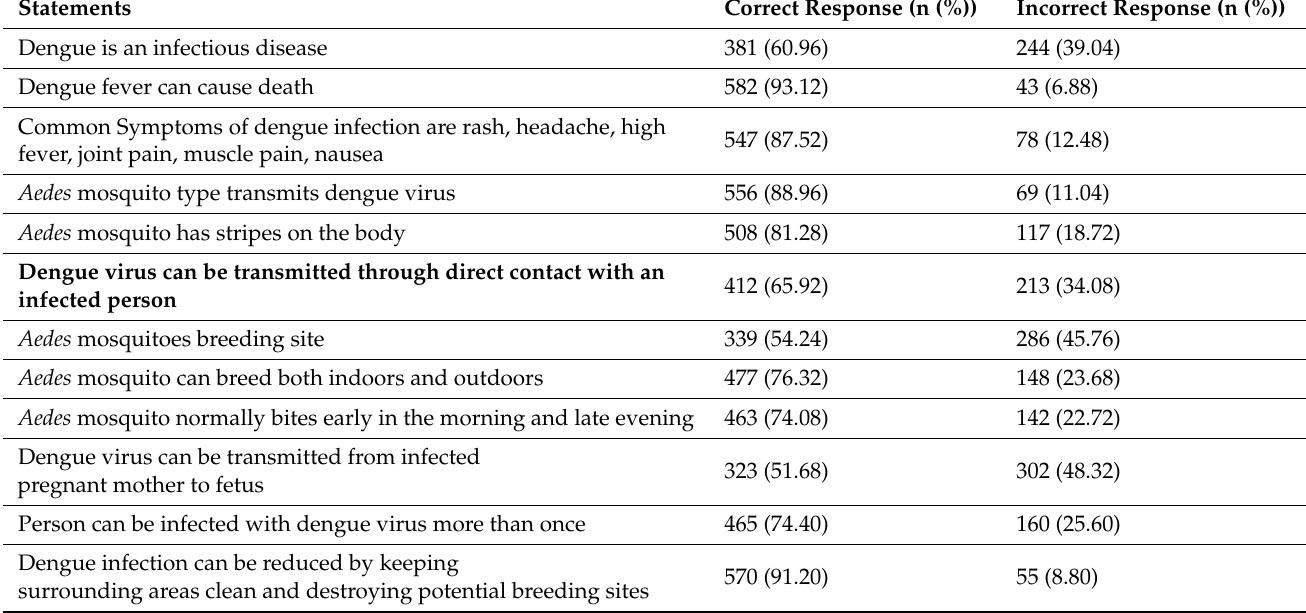
Table 2. Knowledge regarding dengue fever among university students of Dhaka city,